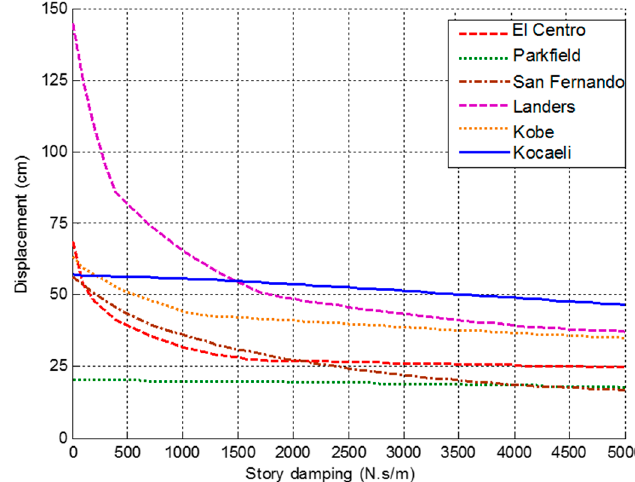
Figure 8. Peak displacement for the top story of building with respect to story damping.